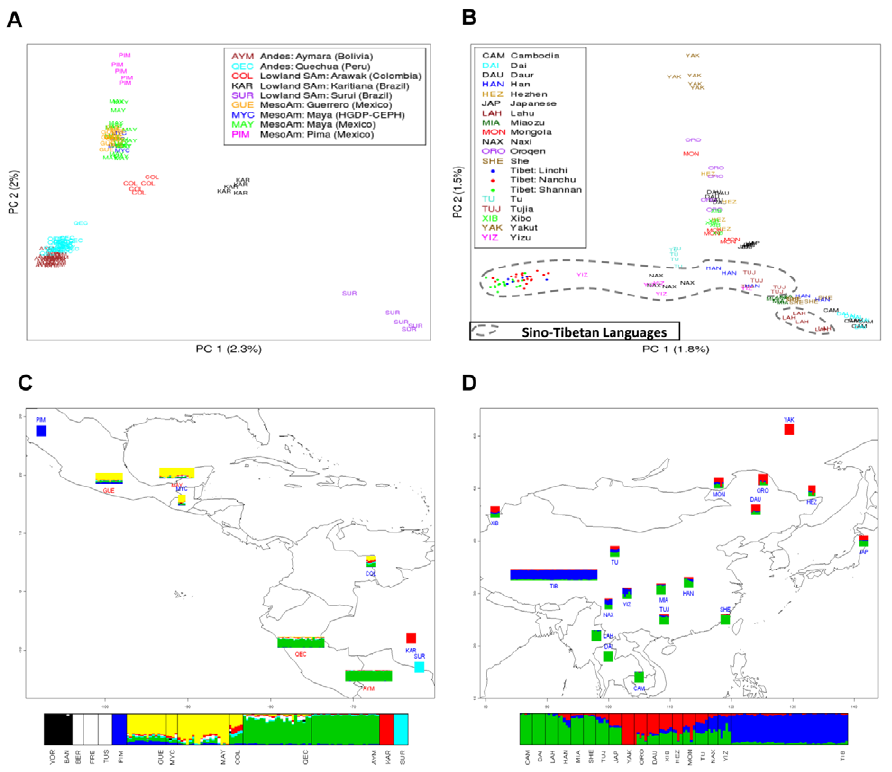
Figure 2. Individual ancestry estimates. (A) Indigenous American individual genetic structure using PCA with a set of 221,046 SNPs selected to remove the influence of European admixture (see Materials and Methods and Figure S1) Europeans have been removed to simplify the representation; (B) East Asian individual genetic structure using PCA with the full set of 439,046 SNPs; (C) Frappe map file showing Indigenous American and (D) East Asian population structure. Population abbreviations are as in Figure 2A and Figure 2B, respectively. Additional European and African populations are included in the frappe bar chart in Figure 2C, and include Yoruban (YOR), Bantu (BAN), Berber (BER), French (FRE), and Tuscan (TUS). Each individual is represented by a vertical line that is divided into colored segments representing the genomic contribution from a particular K ancestral cluster.